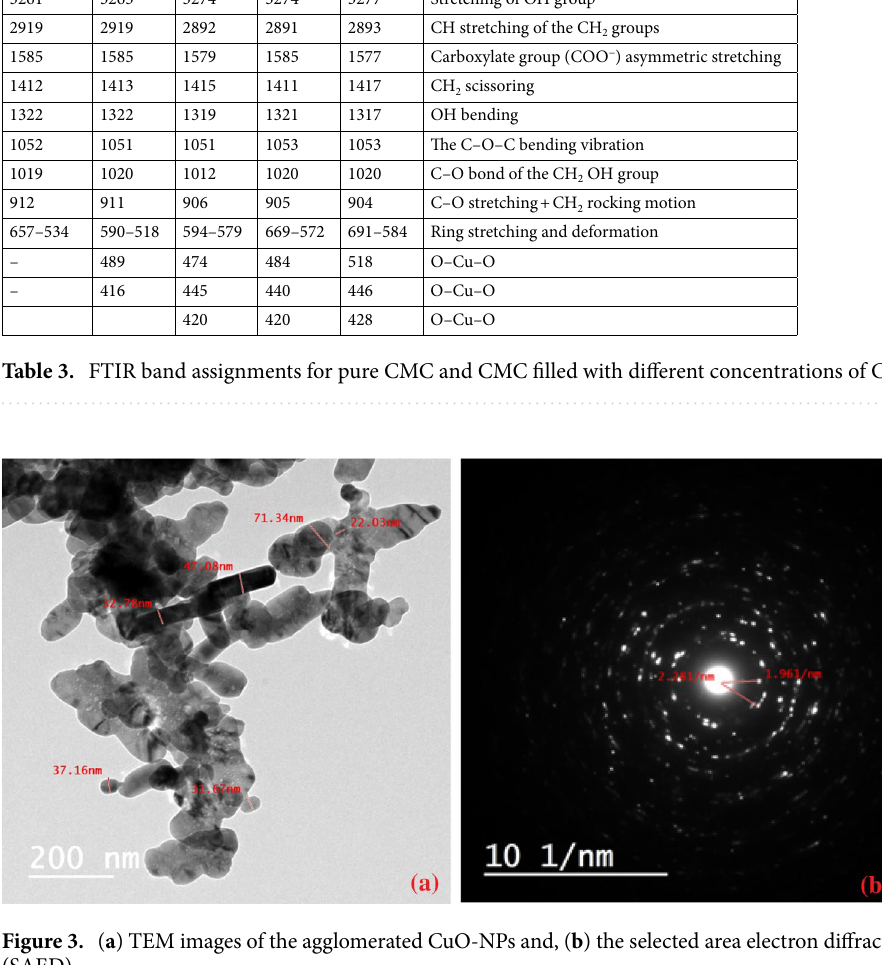
Figure 3. ( a ) TEM images of the agglomerated CuO-NPs and, ( b ) the selected area electron diffraction pattern